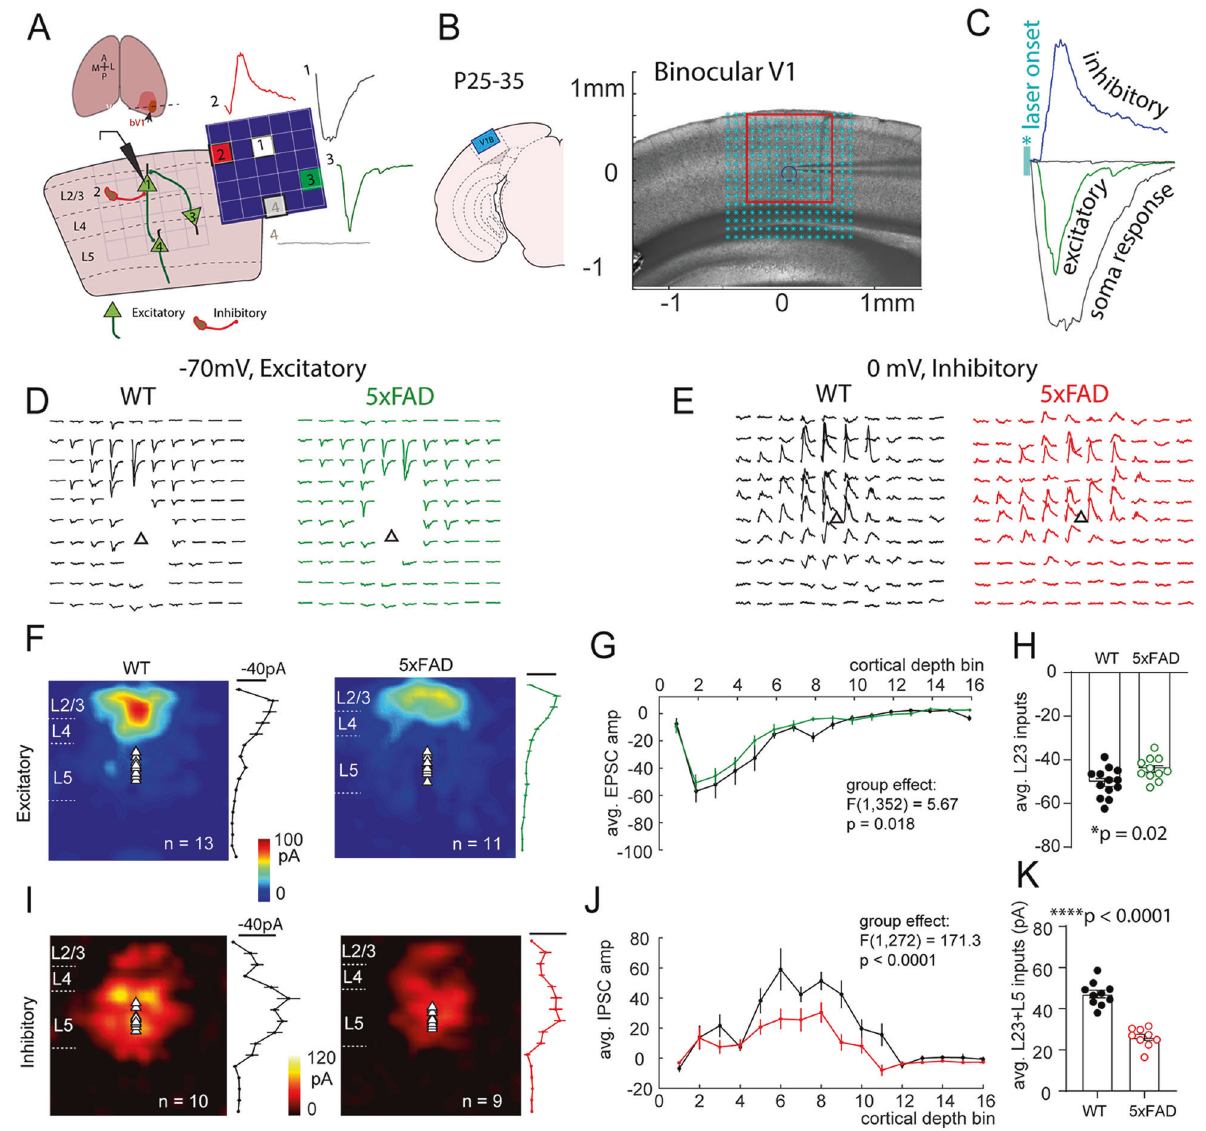
Fig. 5 VC-L5 neurons from 5XFAD mice show reduced intracortical synaptic connectivity during critical period. A Schematic illustration of a VC slice preparation, LSPS mapping in which different stimulus (laser uncaging) locations relative to recorded V5 neurons lead to direct soma (1), inhibitory (2), or excitatory synaptic (3) currents. B Illustration and digital image of VC slice with registered LSPS mapping grid. LSPS mapping was performed on the L5 pyramidal neuron. A 16 × 16 stimulus grid was centered on bV1 with top row aligned with pia surface. Cyan asterisks indicate glutamate uncaging locations. C LSPS mapping/glutamate uncaging at different locations can elicit direct soma responses, excitatory synaptic responses (EPSC), inhibitory synaptic response (IPSC), or no response. D Representative 10 × 10 mapping traces (corresponding to red square areas in B ) of excitatory responses from 5XFAD and WT neurons. Traces contaminated by direct soma responses were removed from display. Triangle indicates soma location. E Representative 10 × 10 mapping traces of inhibitory responses from 5XFAD and WT neurons. F Averaged excitatory connectivity map from WT ( n = 13 cells/8 mice) and 5XFAD ( n = 11 cells/8 mice) neurons. Averaged strength of synaptic inputs binned by cortical layers are plotted to the right . G 5XFAD neurons show signi fi cantly altered laminar inputs (main effect of group, F (1,352) = 5.67, p = 0.018. Two-way ANOVA). H Combined L2/3 inputs from 5XFAD neurons show a signi fi cant reduction in connectivity strength (* p = 0.02). I Averaged inhibitory connectivity map from WT ( n = 10 cells/8 mice) and 5XFAD ( n = 9 cells/7 mice) neurons. Averaged strength of inhibitory synaptic inputs binned by cortical layers are plotted to the right. J 5XFAD neurons show signi fi cantly altered laminar inputs (F (1,272) = 171.3, **** p < 0.0001. Two-way ANOVA). K Combined inhibitory inputs from L2/3 and L5 also show a signi fi cant reduction in 5XFAD neurons (t 17 = 8.6, *** *p <